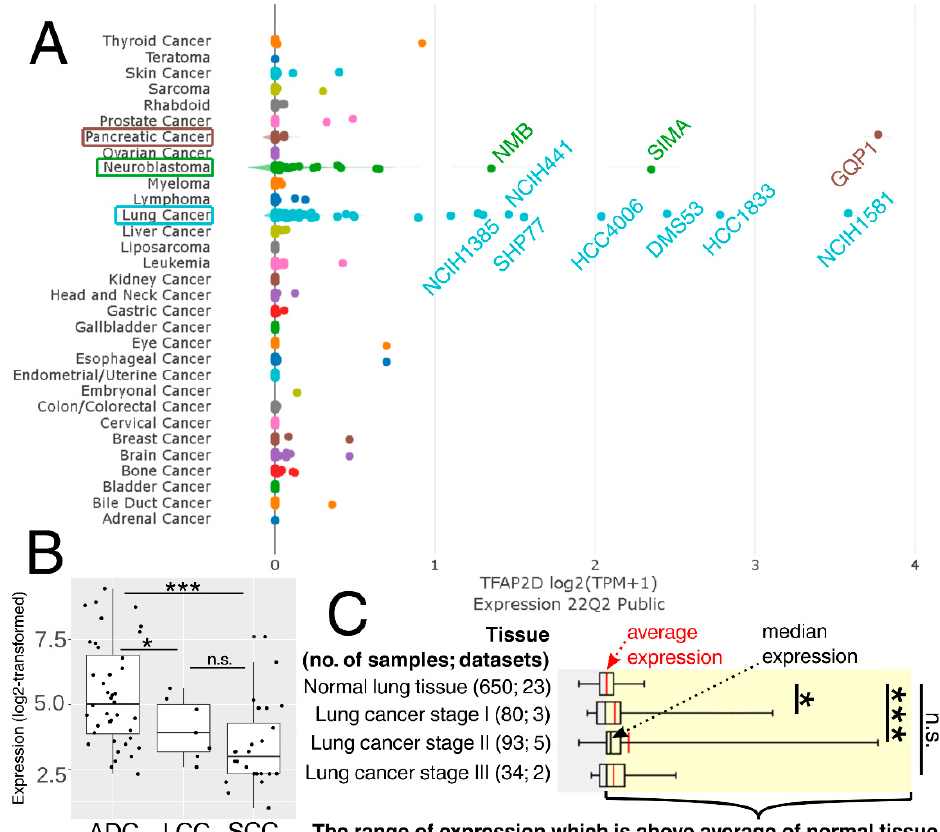
Figure 13. Expression of TFAP2D in pan-cancer cell lines ( A ), as well as lung carcinoma histological types ( B ) and stages ( C ). The names of ten cancer cell lines having the highest expression are included. ADC–lung adenocarcinoma. LCC—lung large cell carcinoma. SCC—lung squamous cell carcinoma. p > 0.05 (n.s.), p < 0.05 (*), p < 0.001 (***). Data acquired from DepMap, GENT2, and Oncopression.